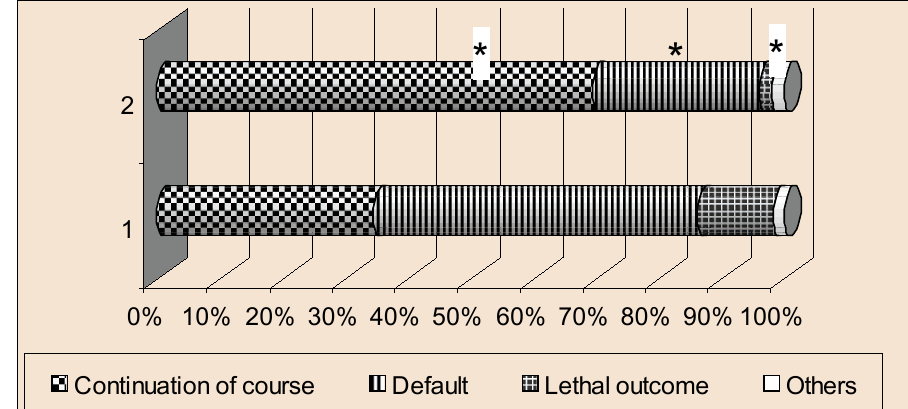
*-P<0,05 compared to the patients-carriers of M.tuberculosis with mutation in katG